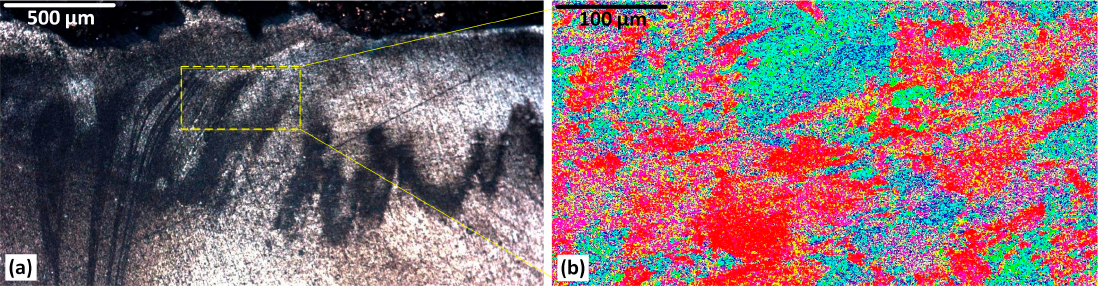
Figure 7. The microstructure of the Sub-shoulder region, ( a ) Optical microscopy and ( b ) EBSD colour map. The selected area from the sub-shoulder region shown in Figure 7a has been mapped by the EBSD analysis in Figure 7b. The crystallographic texture at the sub-shoulder region is complex. This